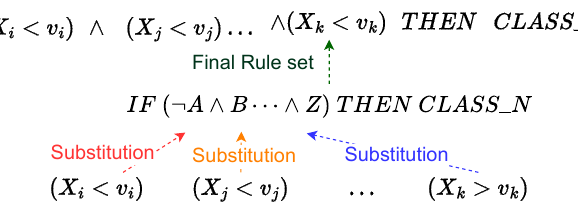
Figure 6. Substitution and merging process between the intermediate rule sets and the feature rule set employed to generate the final rule